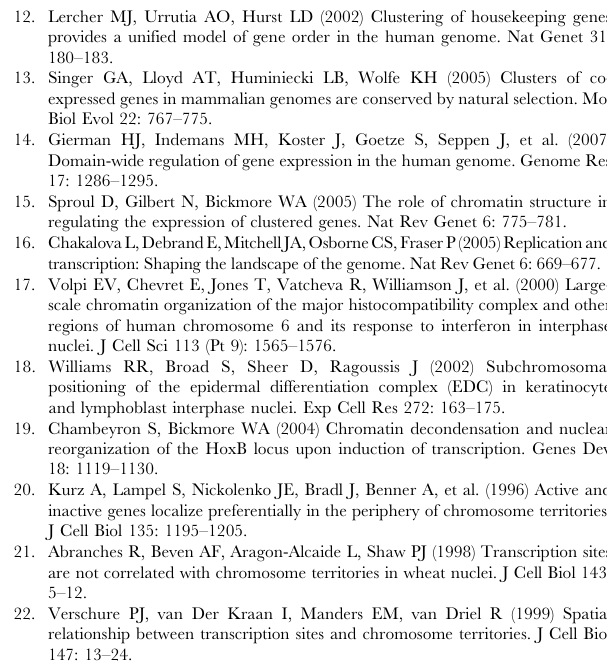
Micro-array data used for Figure 2: Gene Expression Omnibus (GEO) GSE5891 (E14.5 fetal liver and E14.5 fetal brain) and ArrayExpress E-MEXP-839 (adult liver) [61,62].